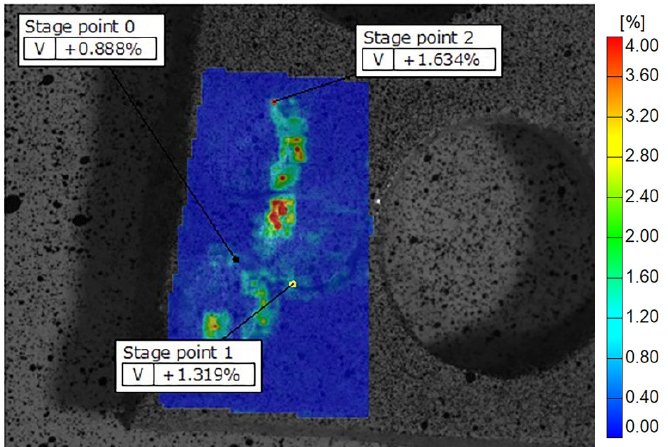
Figure 9. Display of Well Root PT deformation fields across the samples on Teflon discs, showing peripheral zones with higher and central zones with lower strain values. The color scale indicates different strain values, with the highest marked in red and orange. Some of the recorded reference points are shown as stage points 0, 1 and 2. Table 2. Nested ANOVA analysis of significant differences between the materials and Teflon discs in the central (SS) and peripheral (SO) zones.